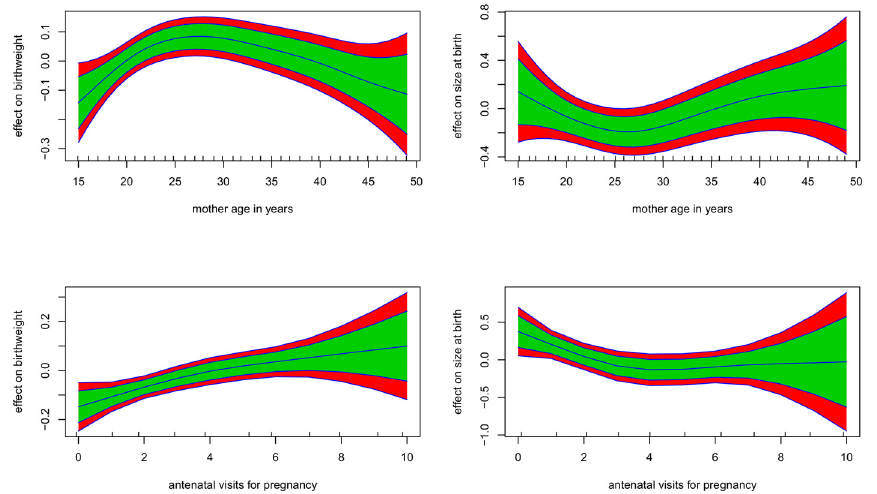
Fig 2. Nonlinear terms from the Gaussian and logistic model (left and right). Red band (95% CI) and green band (80% CI).